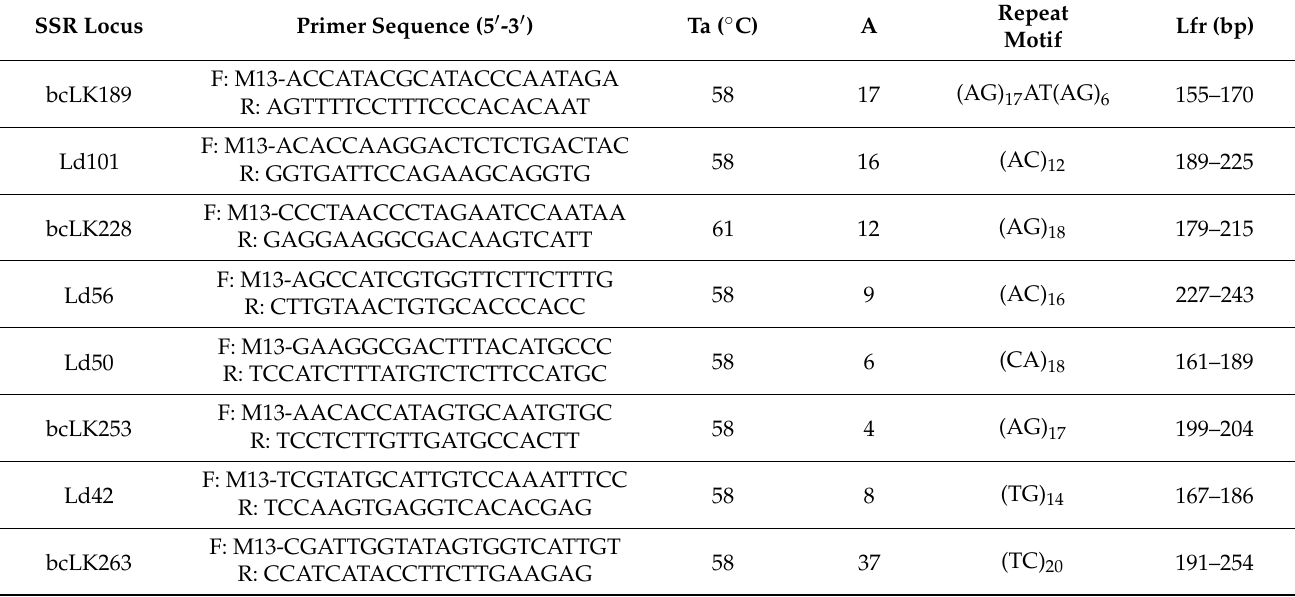
Table 1. Microsatellite primer pairs used to detect polymorphisms of L. sibirica . SSR Locus Primer Sequence (5 (cid:48) -3 (cid:48)